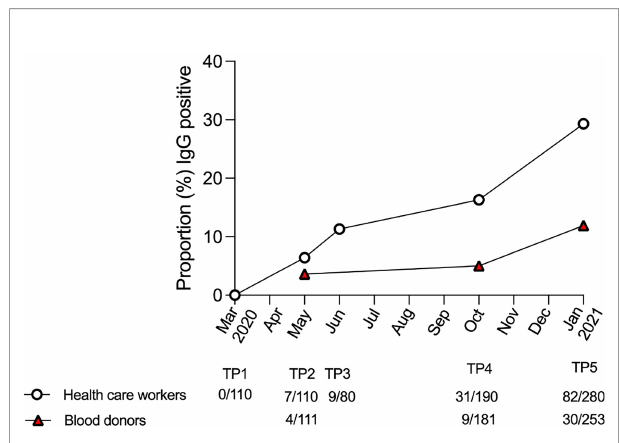
FIGURE 1 | IgG positivity in the N+S assay in health care workers and blood donors over time. Proportion of IgG-positive health care workers (white circles) and blood donors (red triangles), as measured with the N+S-assay, at each sampling time-point (TP) from March 2020 to January